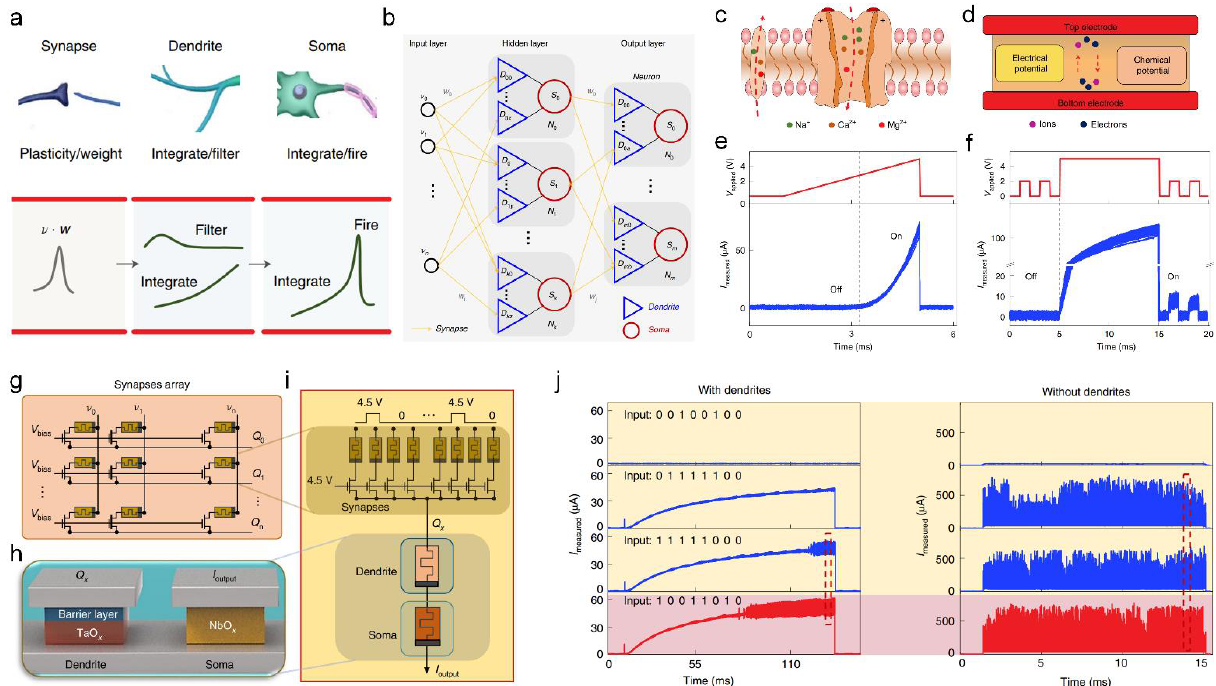
Figure 6. ( a – d ) Comparison of biological and artificial neural networks. ( a ) Components of a biological neural network and their corresponding functionalities. ( b ) Artificial neural networks comprising an input layer, hidden layer, and output layer. ( c ) Operation mechanism in a biological dendrite. ( d ) Conventional metal-oxide-based memristor mimicking a biological synapse. Measured electrical response showing ( e ) nonlinearity and ( f ) nonlinear filtering and integration properties. Schematic of ( g ) synapse array and ( h ) artificial dendrite and soma. ( i ) Equivalent circuit diagram comprising ( g , h ). ( j ) Output currents from artificial neural network with dendrites (left) and without dendrites (right) under varying input patterns; adapted with permission from ref. [102], copyright 2020 Springer Nature.